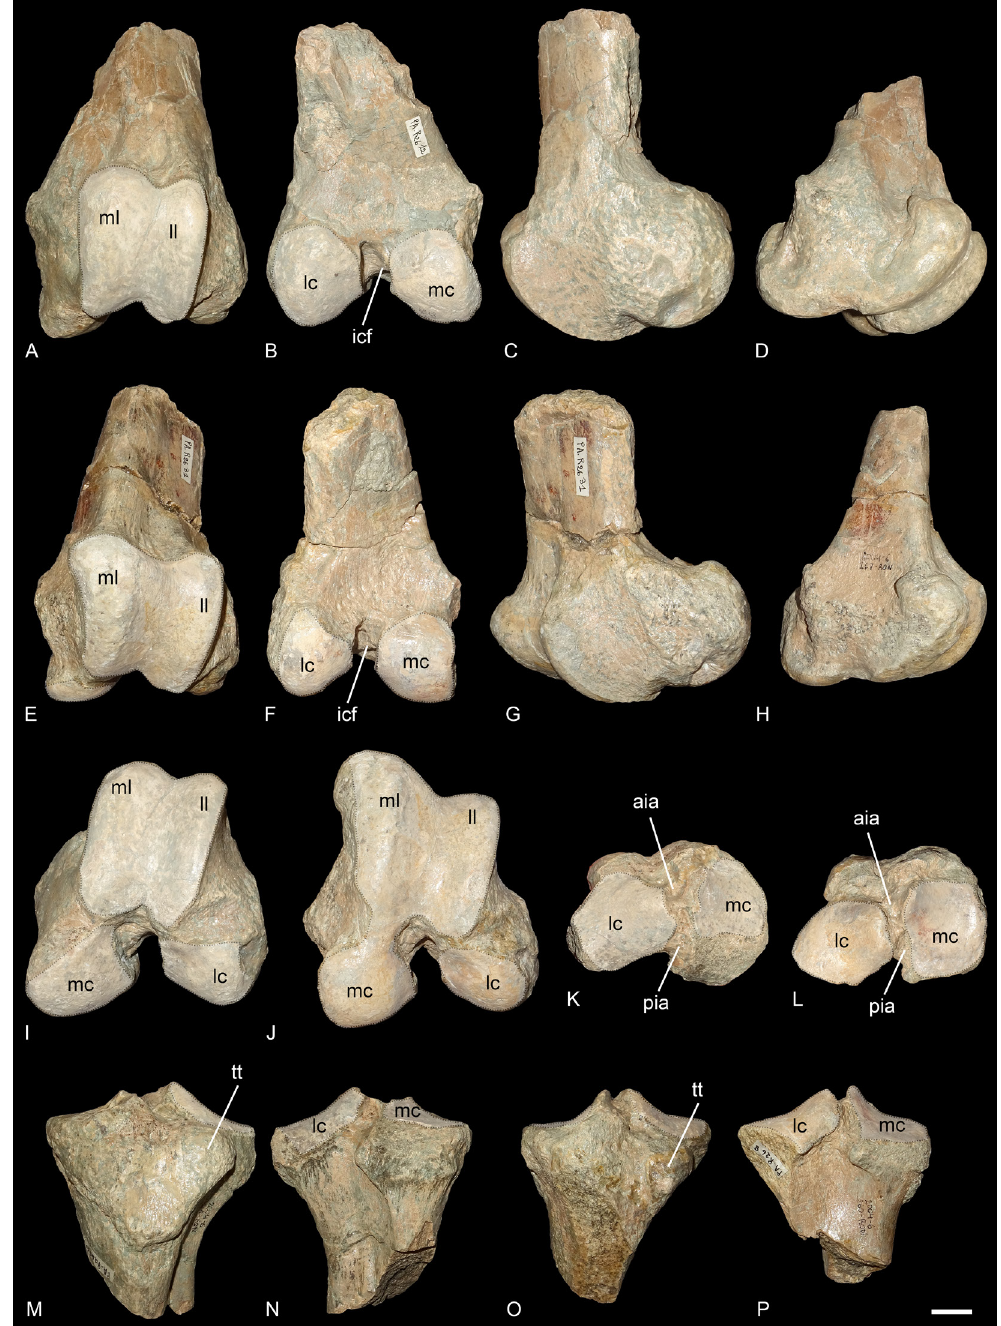
Fig. 6. Ronzotherium velaunum (Aymard in Pictet, 1853) from Ronzon (earliest Oligocene, France). – A–D, I . Left distal femur PUY.2004.6.266.RON. A . Anterior view. B . Posterior view. C . Lateral view. D . Medial view. I . Distal view. – E–H, J . Left distal femur PUY.2004.6.267.RON. E . Anterior view. F . Posterior view. G . Lateral view. H . Medial view. J . Distal view. – K, M–N . Left proximal tibia PUY.2004.6.261.RON. K . Proximal view. M . Anterior view. N . Posterior view. – L, O–P. Left proximal tibia PUY.2004.6.260.RON. L . Proximal view. O . Anterior view. P . Posterior view. Abbreviations: aia = anterior intercondylar area; icf = intercondylar fossa; lc = lateral condyle; ll = lateral lip of the trochlea; mc = medial condyle; ml = medial lip of the trochlea; pia = posterior intercondylar area; tt = tibial tuberosity. Articular surfaces highlighted in white. Scale bar: 2